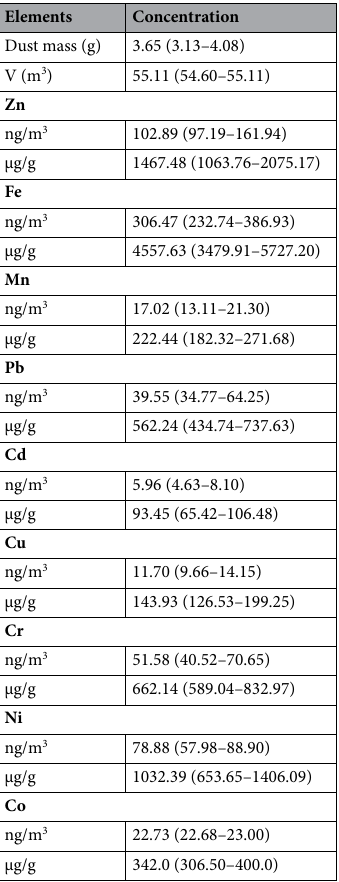
Table 2. The characteristic of heavy metals in UPM. The results are presented as median and